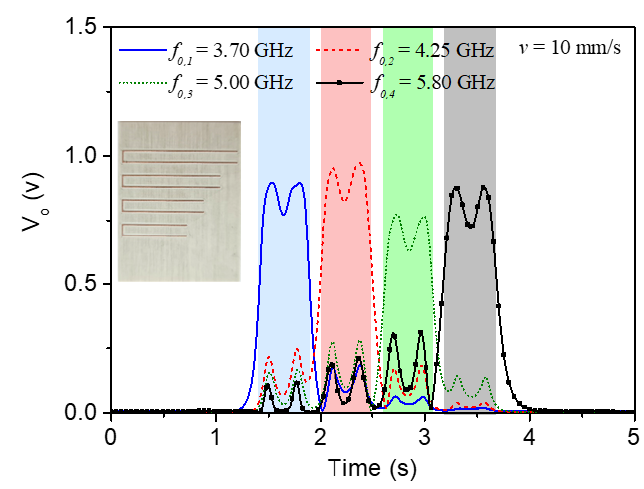
Figure 13. Envelope functions for the four frequencies corresponding to the (second) resonances of the four C-shaped resonators, for the tag depicted in the inset.